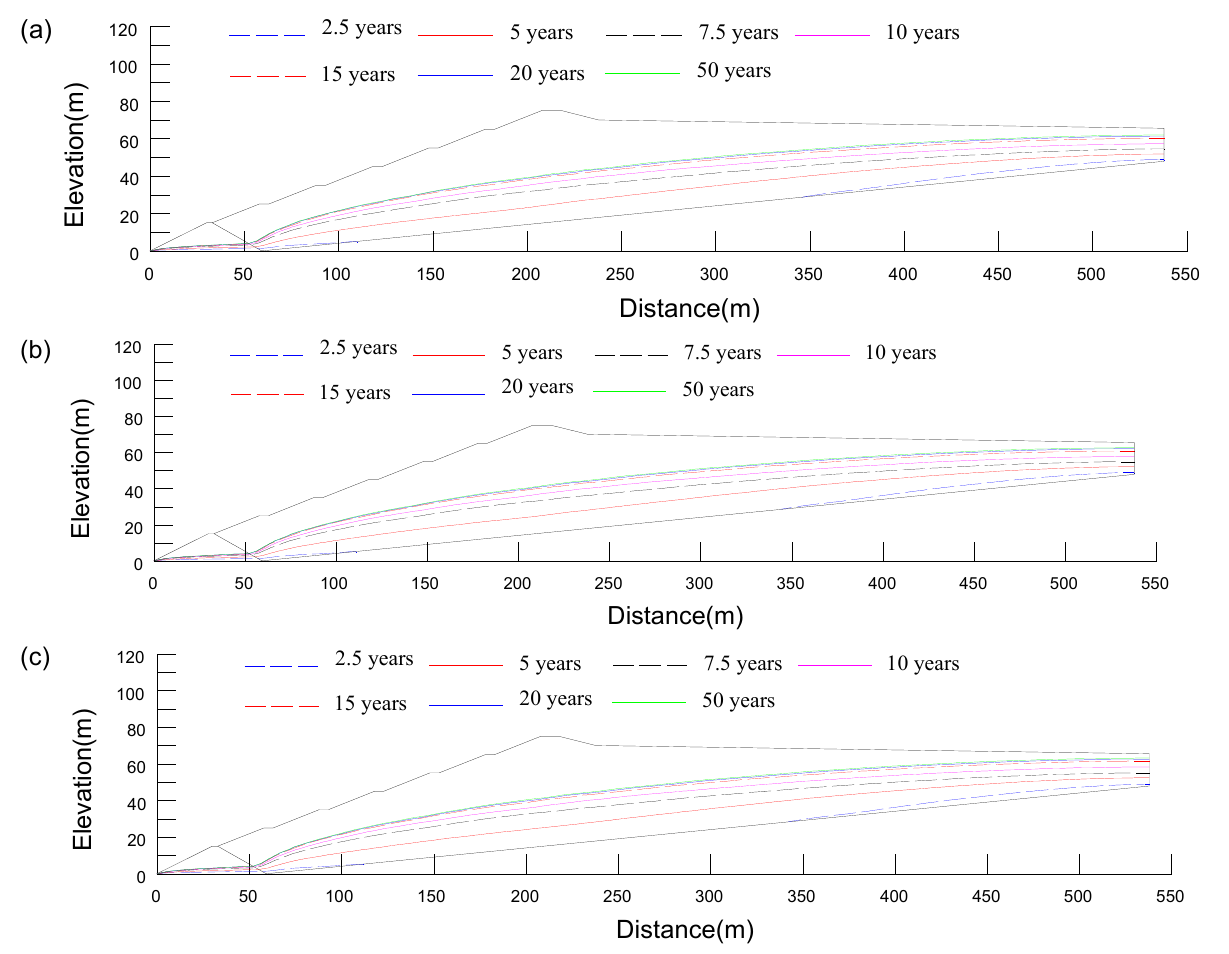
Figure 8. The spatial ‐ temporal evolution law of the saturation line in the tailings pond (Guiyang, 1200 mm): ( a ) Guiyang 2018 (caseII ‐ g); ( b ) Guiyang 2019 (caseII ‐ h); ( c ) Guiyang 2020 (caseII ‐ i).